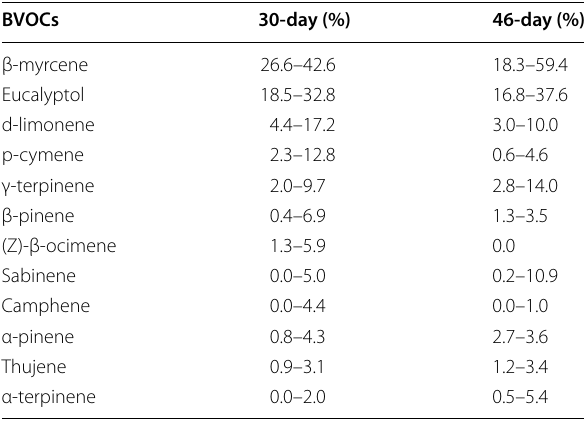
Note: BVOCs biogenic volatile organic compounds Data adapted from Wang, C. T., Wiedinmyer, C., Ashworth, K., Harley, P. C., Ortega, J., Vizuete, W. (2019b). Leaf enclosure measurements for determining volatile organic compound emission capacity from Cannabis spp. Atmos. Environ., 199, 80–87. (Wang et al.,